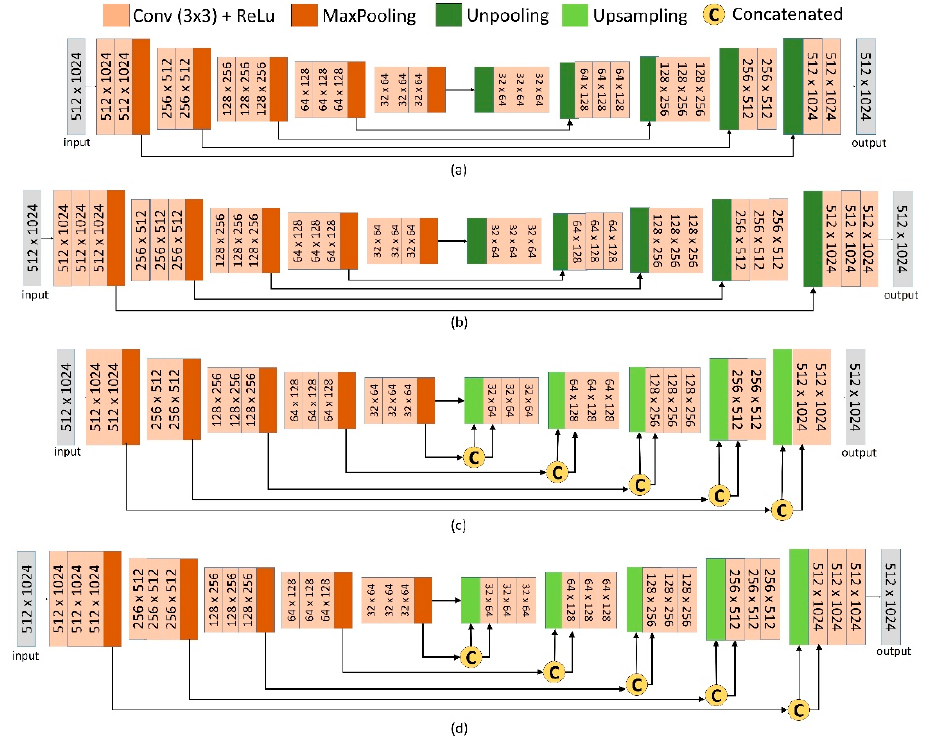
Figure 10. CNN Network architecture. ( a ) VGG16 + SegNet, ( b ) ResNet50 + SegNet, ( c ) VGG16 + UNet, ( d ) ResNet50 + UNet.